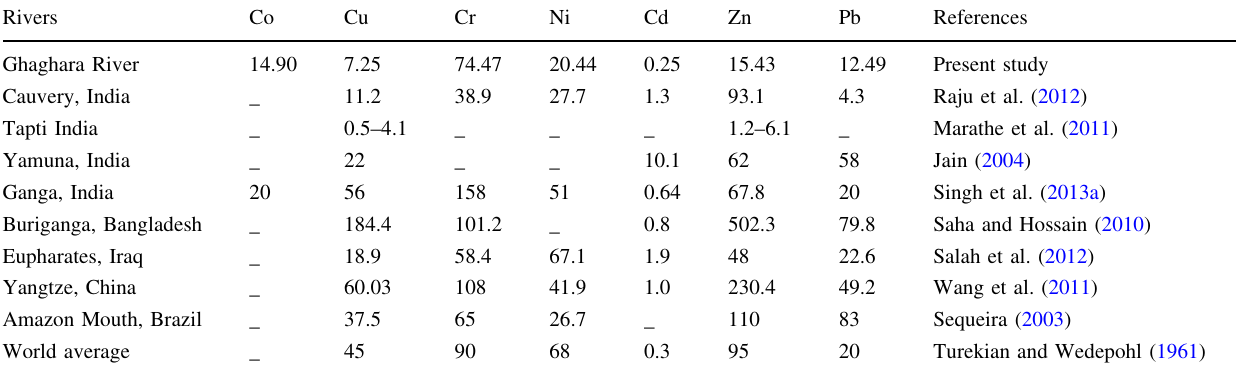
Table 4 Comparison of average concentration (mg/kg) of heavy metals present in sediment of Ghaghara River with other World rivers Rivers